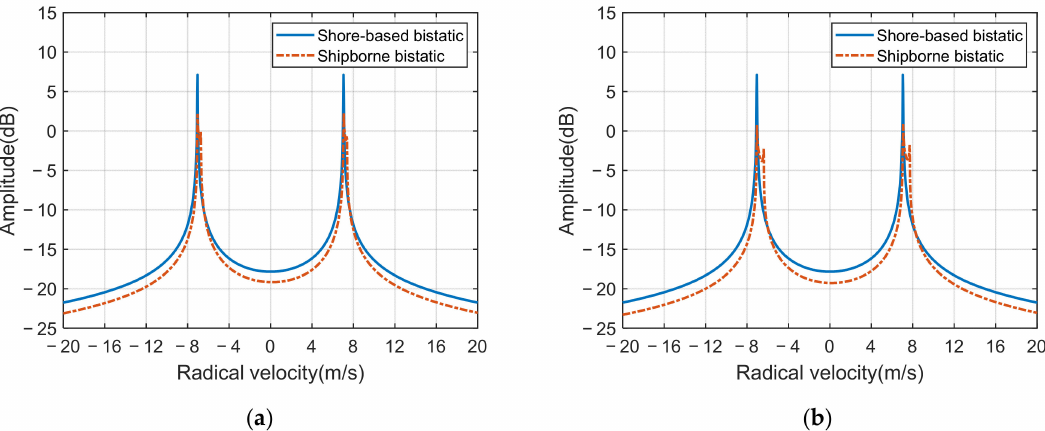
Figure 5. Simulated shipborne bistatic (red dotted line) and shore-based bistatic (blue solid line) first-order Doppler spectra for different motion velocities. ( a ) The motion speed of the shipborne bistatic radar is 5 m/s. ( b ) The motion speed of the shipborne bistatic radar is 10